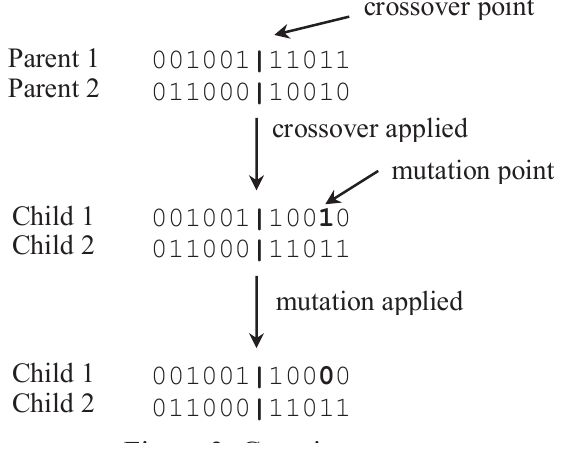
Figure 3. Genetic operators. Figure 3: Genetic